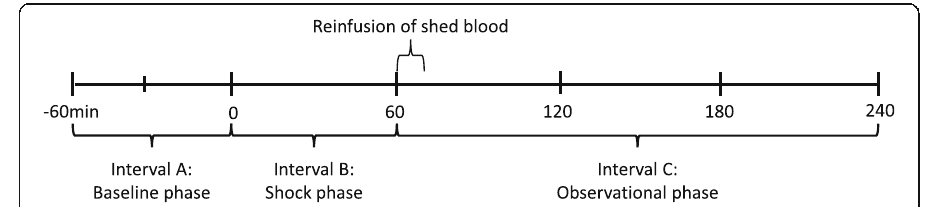
Fig. 1 Experimental protocol timeline. Note that the experimental protocol is divided into three intervals. Interval A: baseline phase; interval B: shock phase with a mean arterial pressure of 40 mmHg; and interval C: observational phase after resuscitation with shed